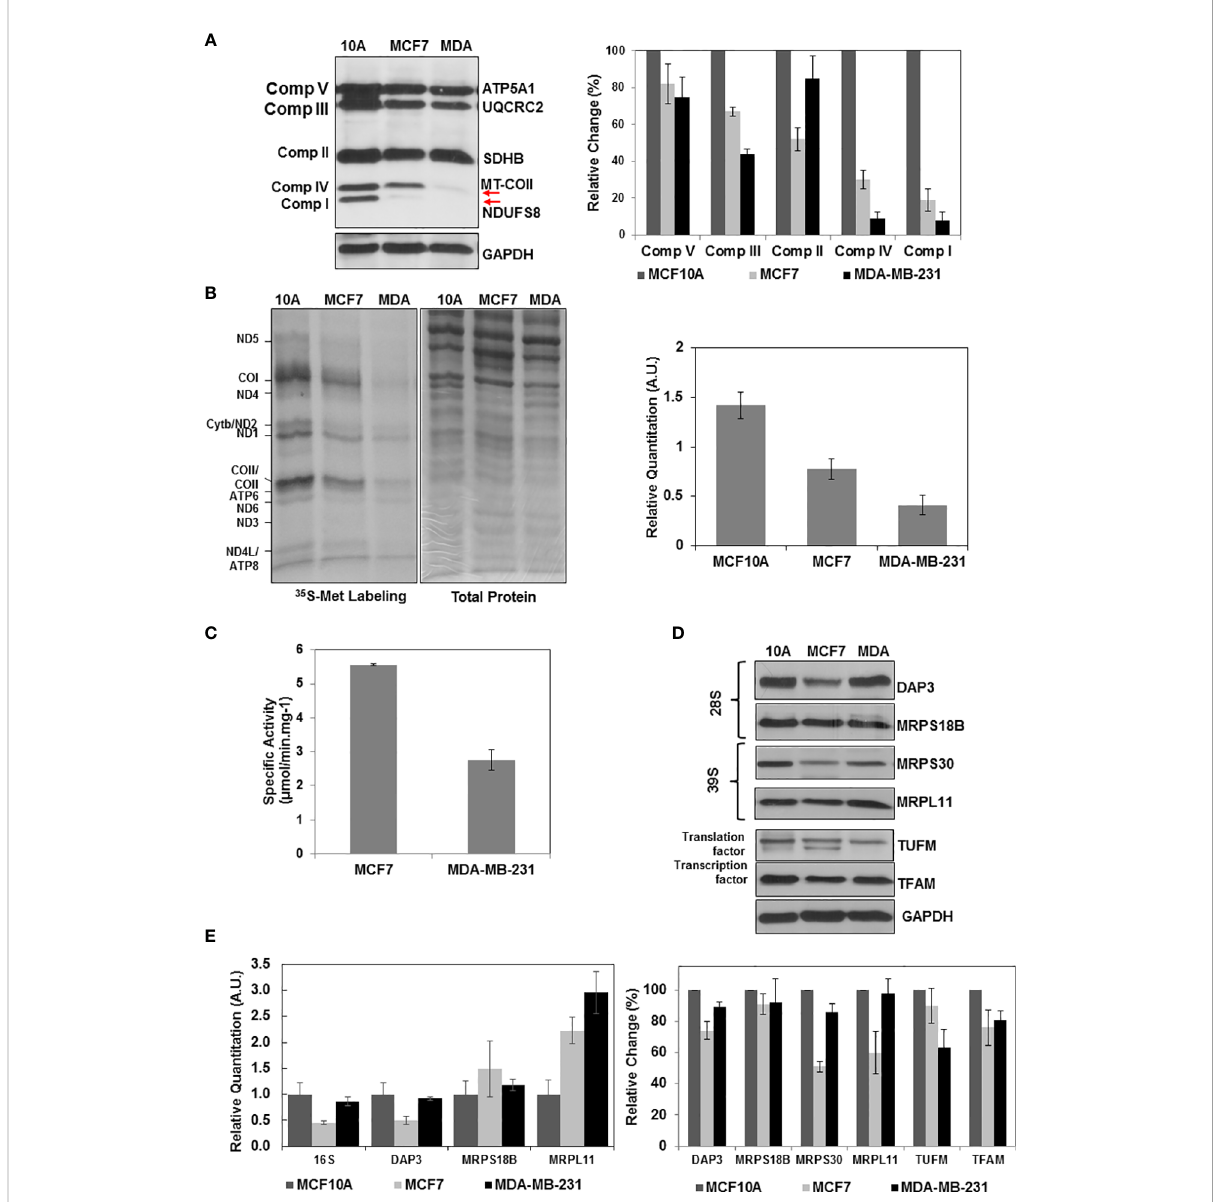
FIGURE 4 Altered OXPHOS subunit expression and mitochondrial translation in breast cancer cell lines. (A) The OXPHOS subunit expression was detected by immunoblotting of approximately 30 m g lysates obtained from breast cancer cell lines MCF10A (10A), MCF7 (MCF7), and MDA-MB-23 (MDA) as described in Figure 1A. The relative quantitation of OXPHOS subunit expression represent the mean ± SD of at least three experiments with MCF10A subunit expression adjusted to 100%. (B) Mitochondrial translation is determined by 35 S-Met pulse labeling of 13 mt-encoded OXPHOS subunits in breast cancer cell lines. The 13 mt-encoded complex I subunits ND1-ND6; complex III subunit cyt b; complex IV subunits COI- COIII; and complex V subunits ATP6 and ATP8 are labeled on the autoradiography of the 13% SDS-PAGE. Total protein loading (30 m g) is visualized by Coomassie Blue staining of the 13% gel. Relative quantitation of mitochondrial translation in MCF10A, MCF7, and MDA-MB-231 cells represents the mean ± SD of the pulse labeling of 13 mt-encoded proteins. (C) The complex IV speci fi c activity was determined using (~20 m g) of MCF7 and MDA-MB-231 cell lysates as described in Figure 1C. (D) Immunoblotting analyses of MRPs (DAP3, MRPS18B, MRPS30, and MRPL11) and mitochondrial translation (TUFM) and transcription (TFAM) related proteins in breast cancer cell lines. Equal protein loading was determined by probing membranes with GAPDH and Ponceau S staining (data not shown). Results represent the mean ± SD of at least three experiments. (E) Relative changes in mt-encoded ribosomal large subunit rRNA, 16S rRNA, and the MRP mRNAs, DAP3, MRPS18B, and MRPL11 were determined by quantitative RT-PCR in the MCF10A, MCF7, and MDA-MB-231 cell lines. Results represent the mean ± SD of at least three experiments adjusted to MCF10A mRNA expression as the